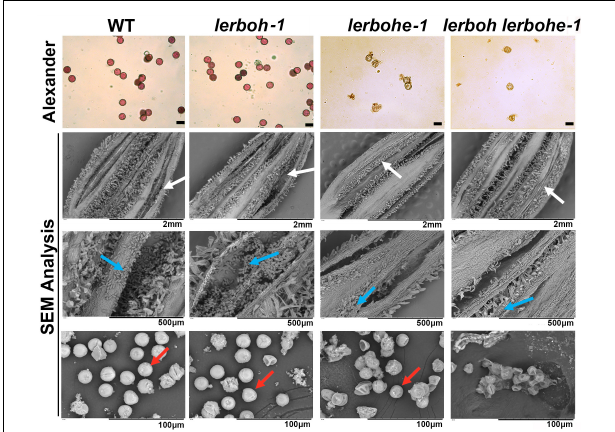
FIGURE 3 | Analysis of pollen morphology and activity in AC, lerboh-1 , lerbohe-1 , and lerboh lerbohe-1 lines. First line, Alexander stain of pollens; second to fourth lines, SEM detection for anthers and pollens. White arrow, anther cracking; blue arrow, pollens; red arrow, pollens with normal morphology. Scale bar in the first line: 20 µ m.